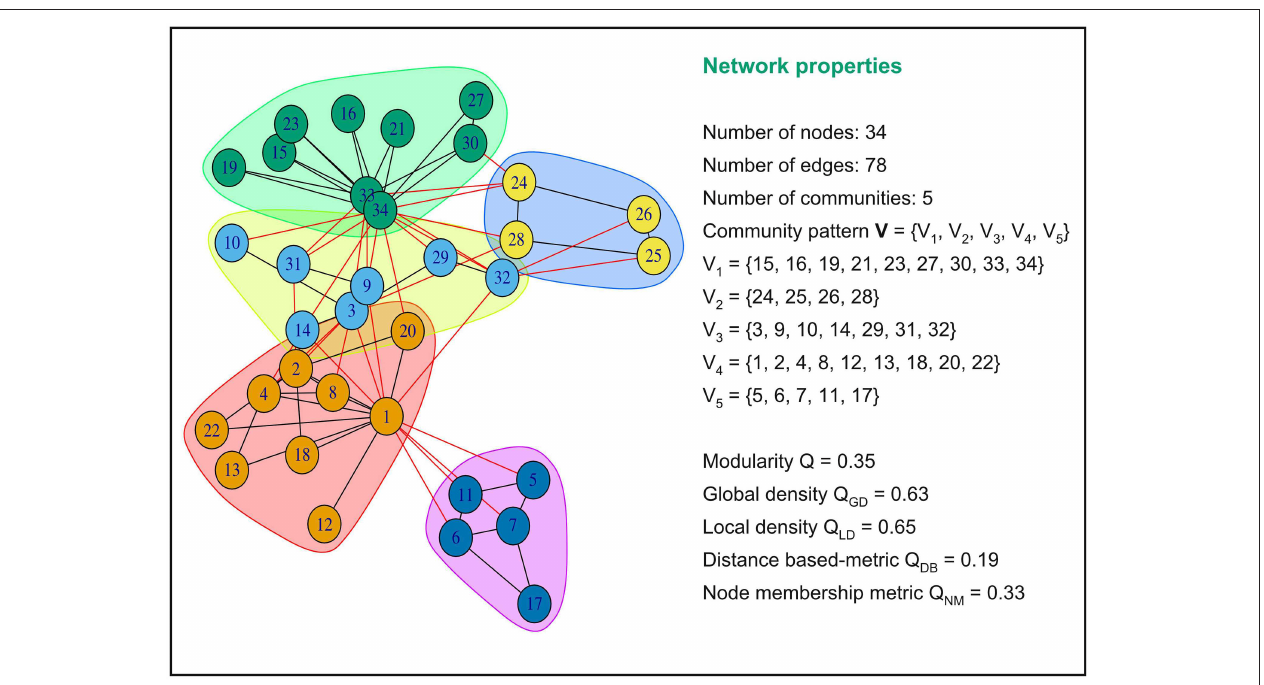
FIGURE 1 | Examples of values of modularity, global density, local density, distance based and node membership metric for a specific community partition of the popular Zachary Karate’s Club network.This network partition is composed of five communities or modules. Intra-community connections are colored in black and inter-community connections in red. The five community pattern measures yielded different values for this graph